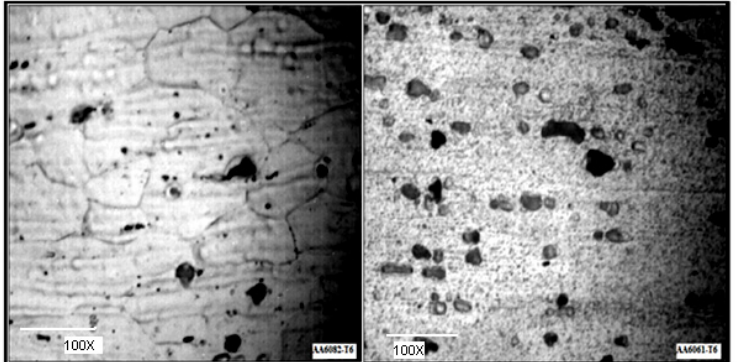
Figure 6: Optical micrograph of base metals AA6082 and AA6061.